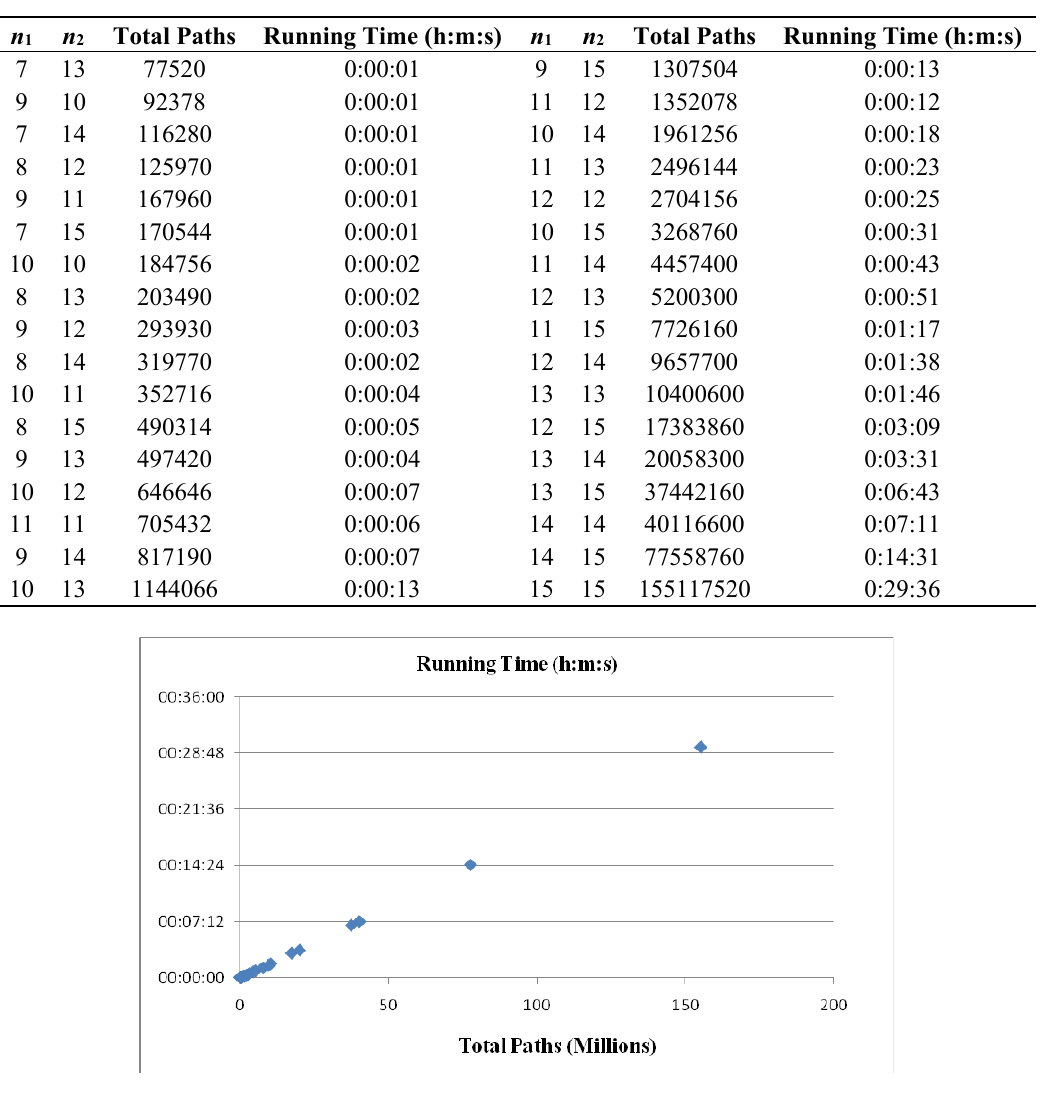
Figure 1. Running Time of G2DLP vs. Total